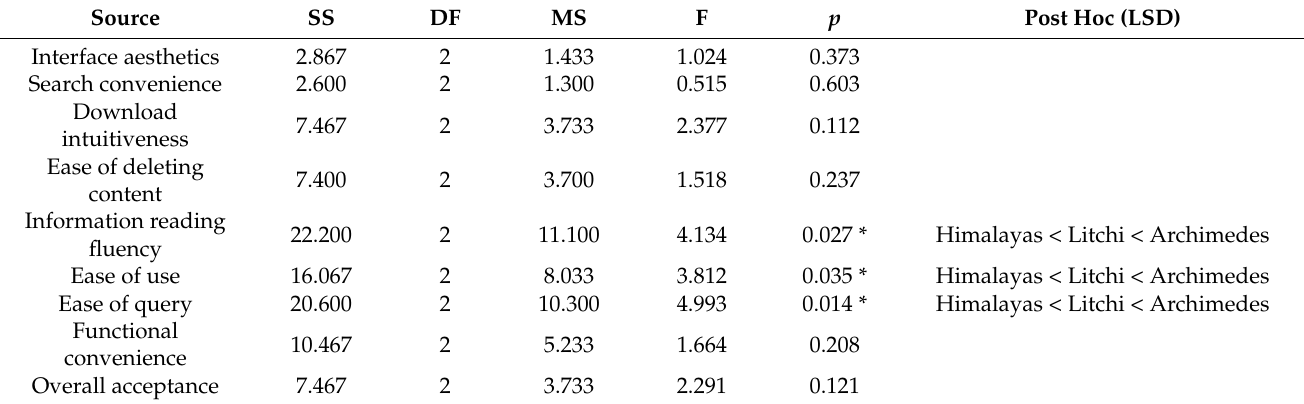
Table 5. The results of the one-way ANOVA regarding participants’ subjective